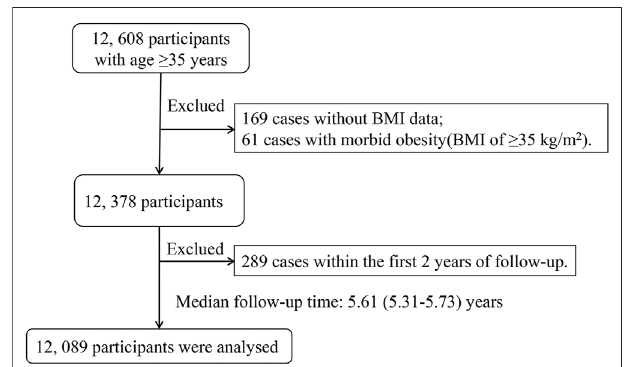
FIGURE 1 | Flow chart of this analysis. Abbreviations: BMI, body mass